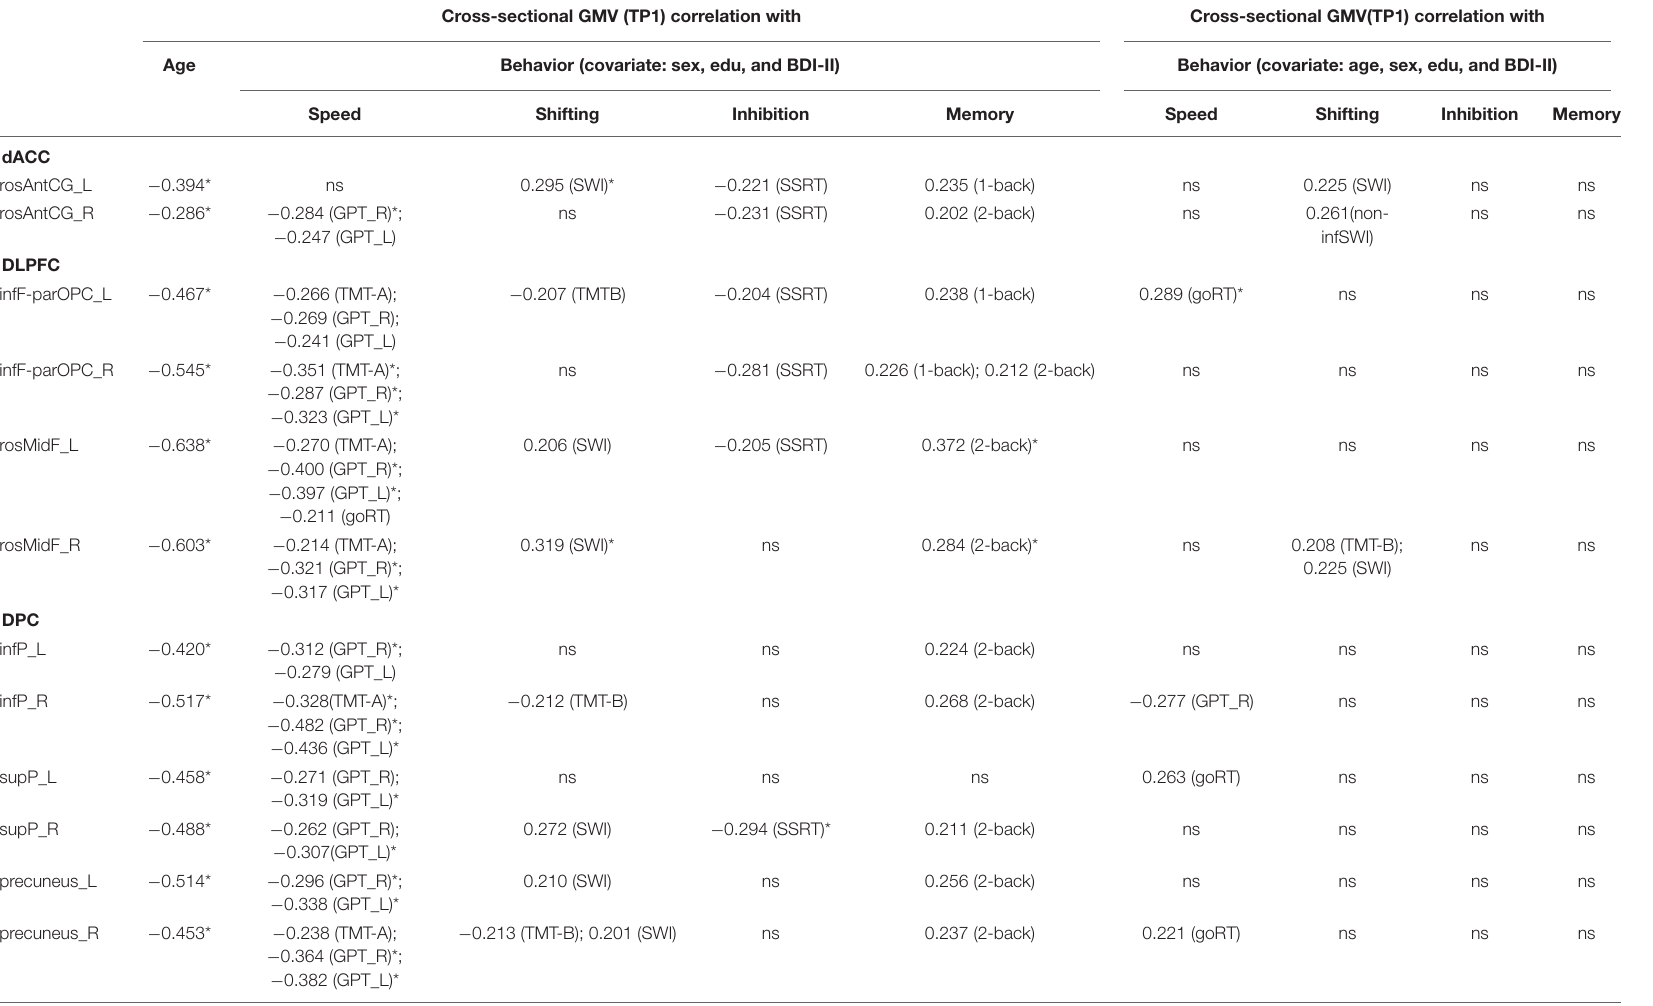
TABLE 4 | Cross-sectional correlation table ( n = 102). Cross-sectional GMV (TP1) correlation with Cross-sectional GMV(TP1) correlation with Behavior (covariate: sex, edu, and BDI-II) Behavior (covariate: age, sex, edu, and